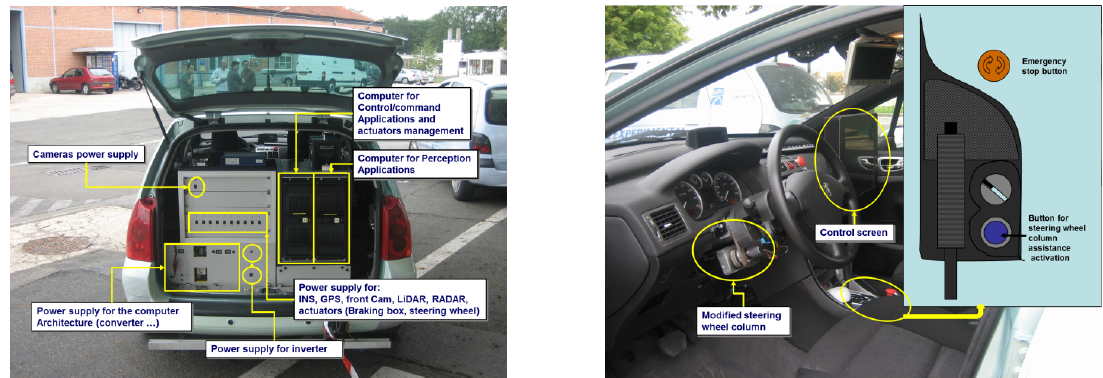
Figure 12. A dedicated real prototype for highly automated driving applications.